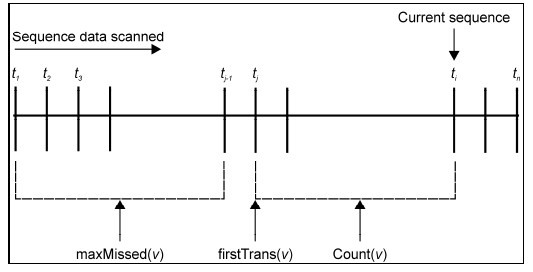
Figure 1. Scan of the equence database